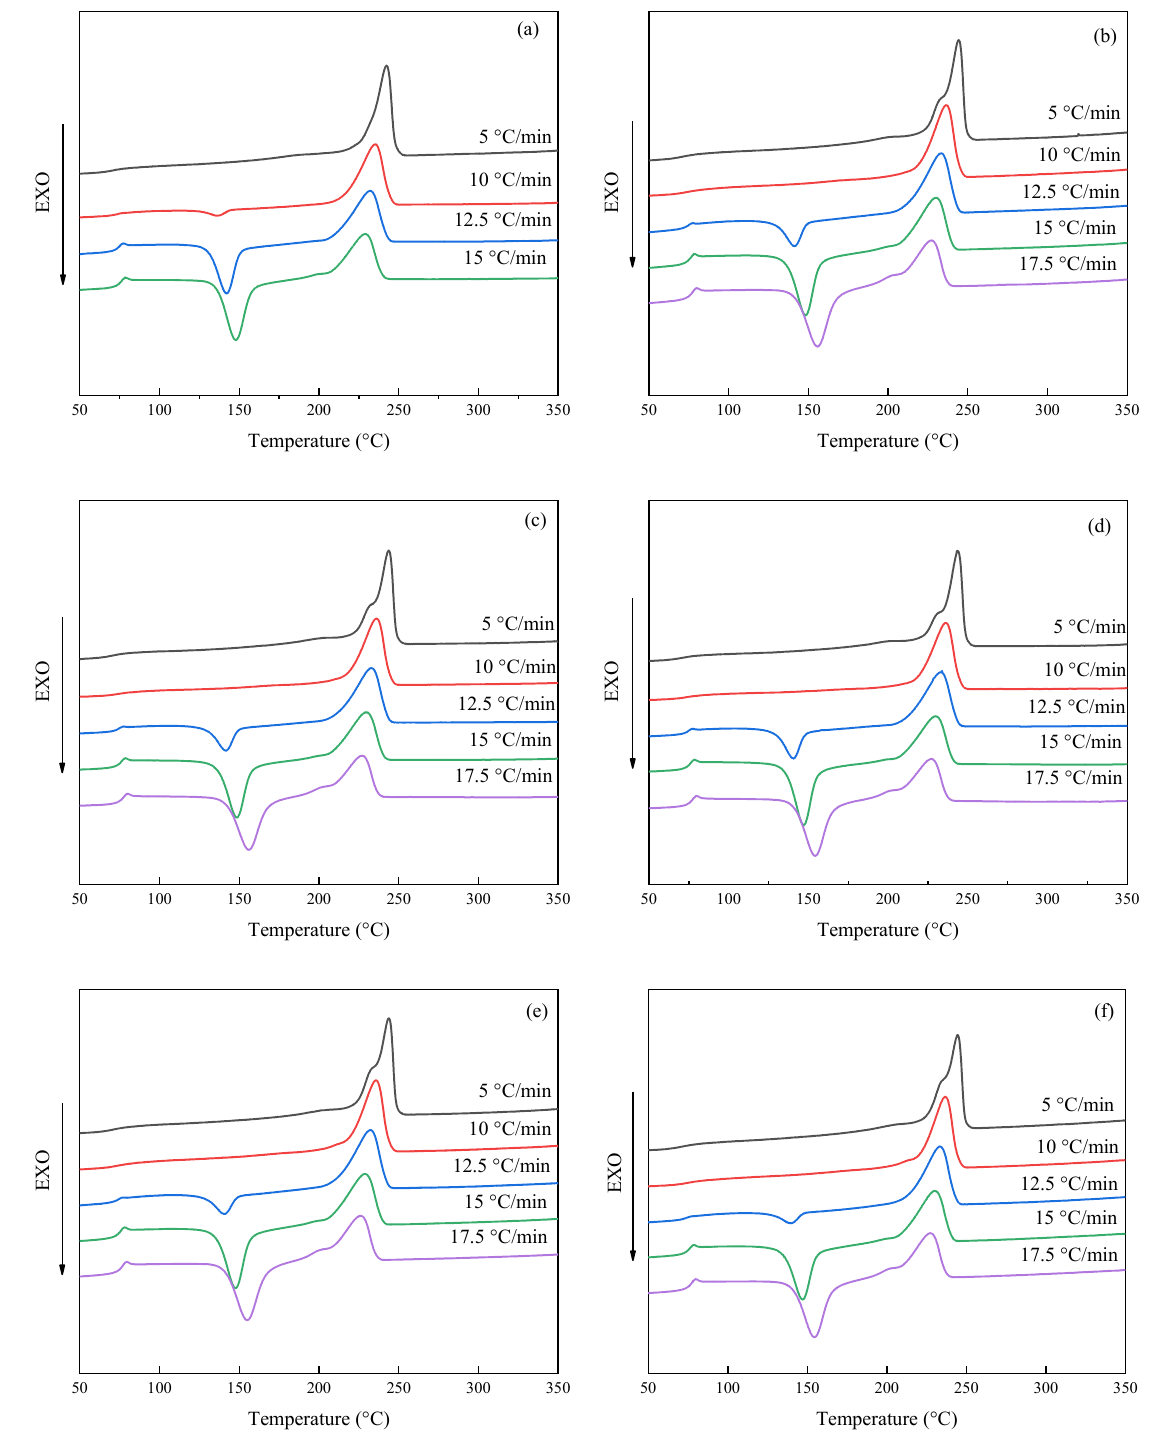
Figure 4. Subsequent heating curves after non-isothermal crystallization. ( a ) PET; ( b ) PSLDH 0.01 wt%; ( c ) PSLDH 0.03 wt%; ( d ) PSLDH 0.05 wt%; ( e ) PSLDH 0.07 wt%; ( f ) PSLDH 0.1 wt%.